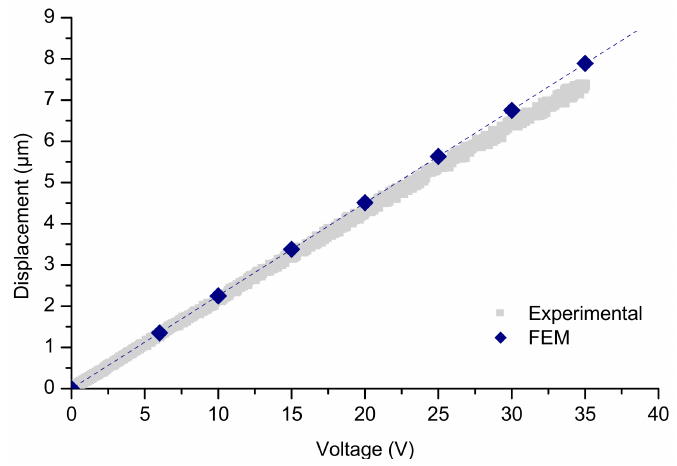
Figure 8. Correspondence between experimental measurements and the FEM model value of a 12 mm membrane maximal displacement as a function of the applied voltage for the first resonance mode.